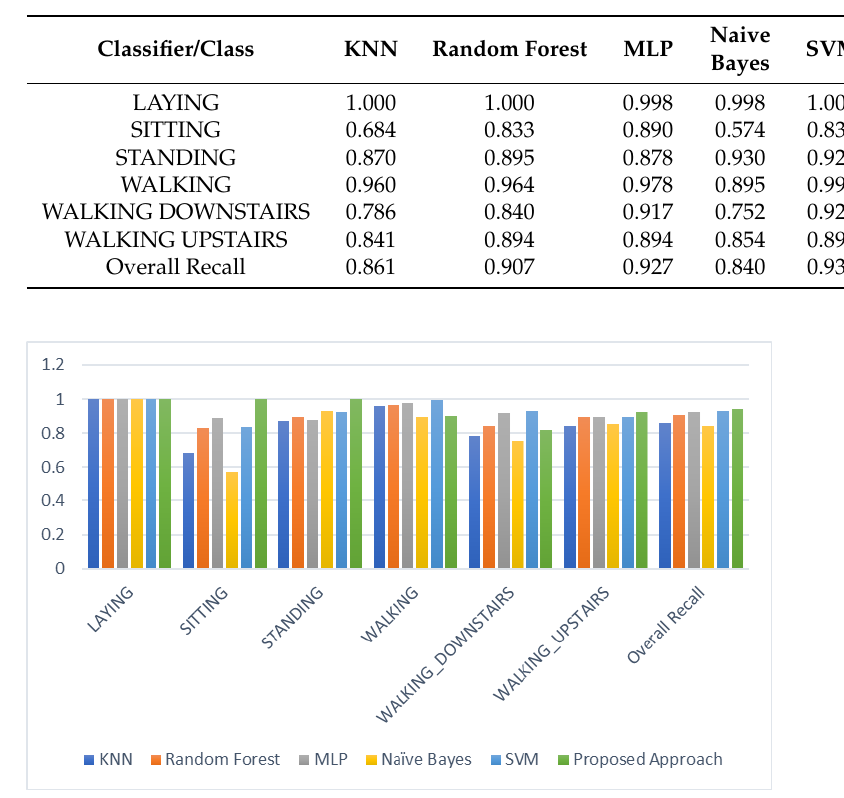
Figure 7. Detailed Precision by Class. Table 4. Detailed Recall by Class.